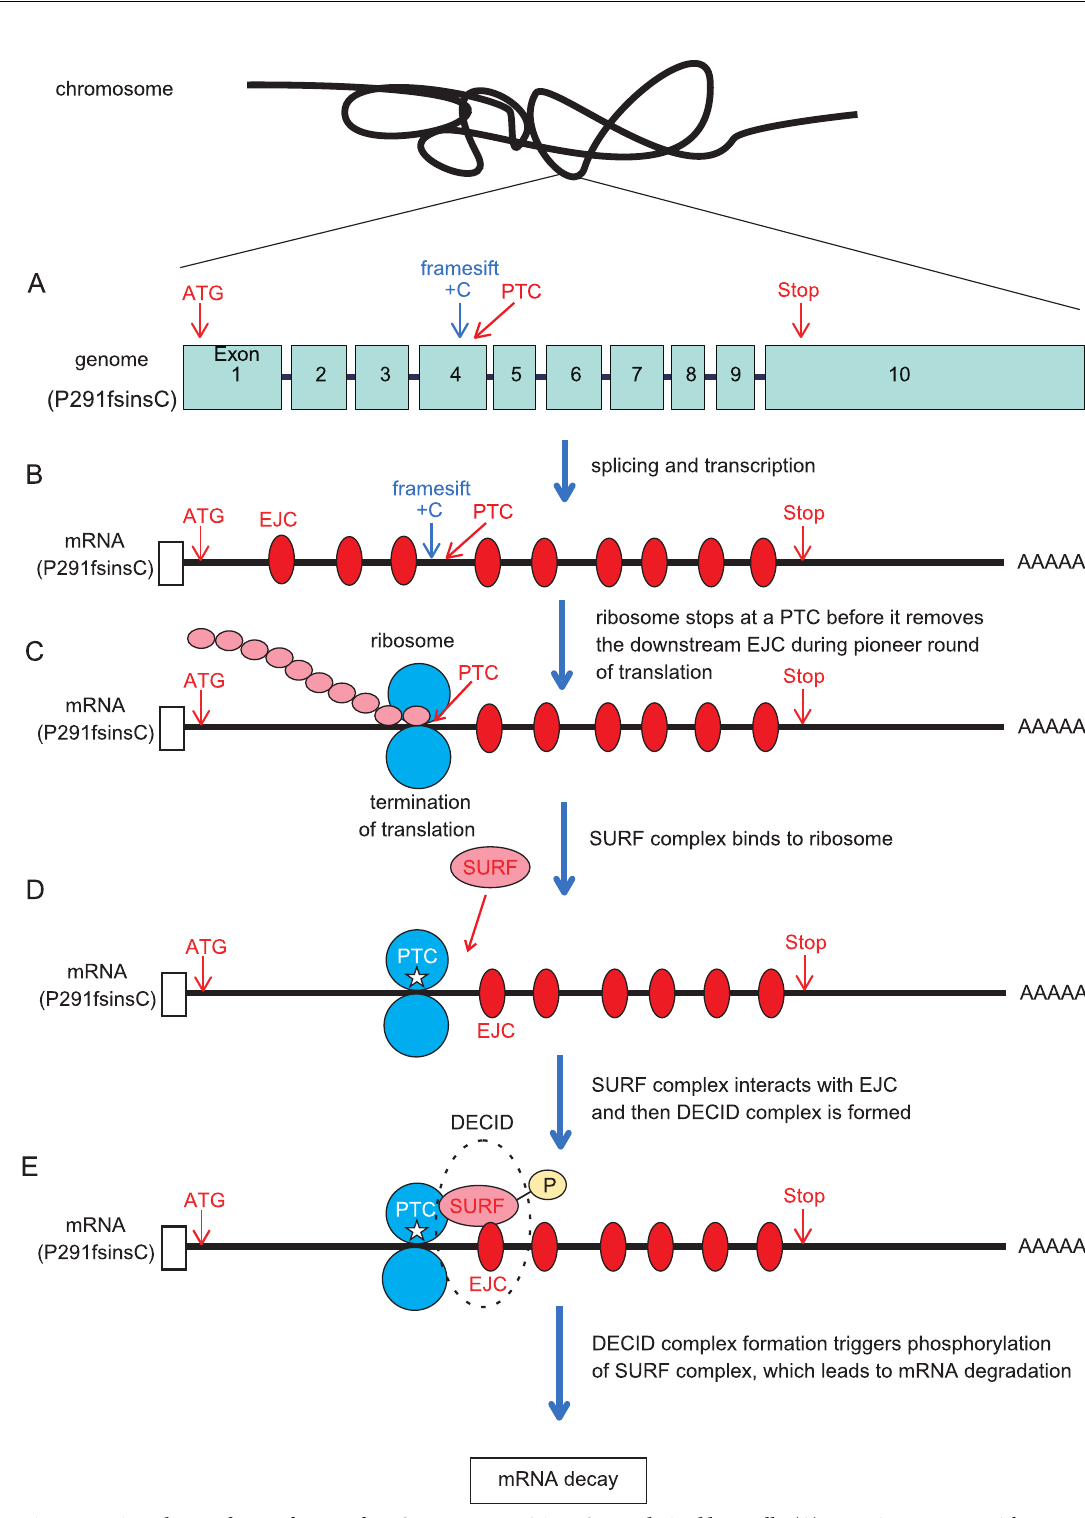
PLOS ONE | https://doi.org/10.1371/journal.pone.0217110 May 30,